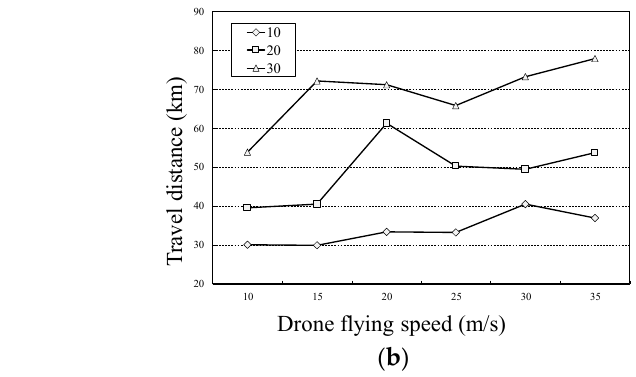
Figure 13. Influence of drone flying speed on time and distance. ( a ) Travel time; ( b ) Travel dis- tance.